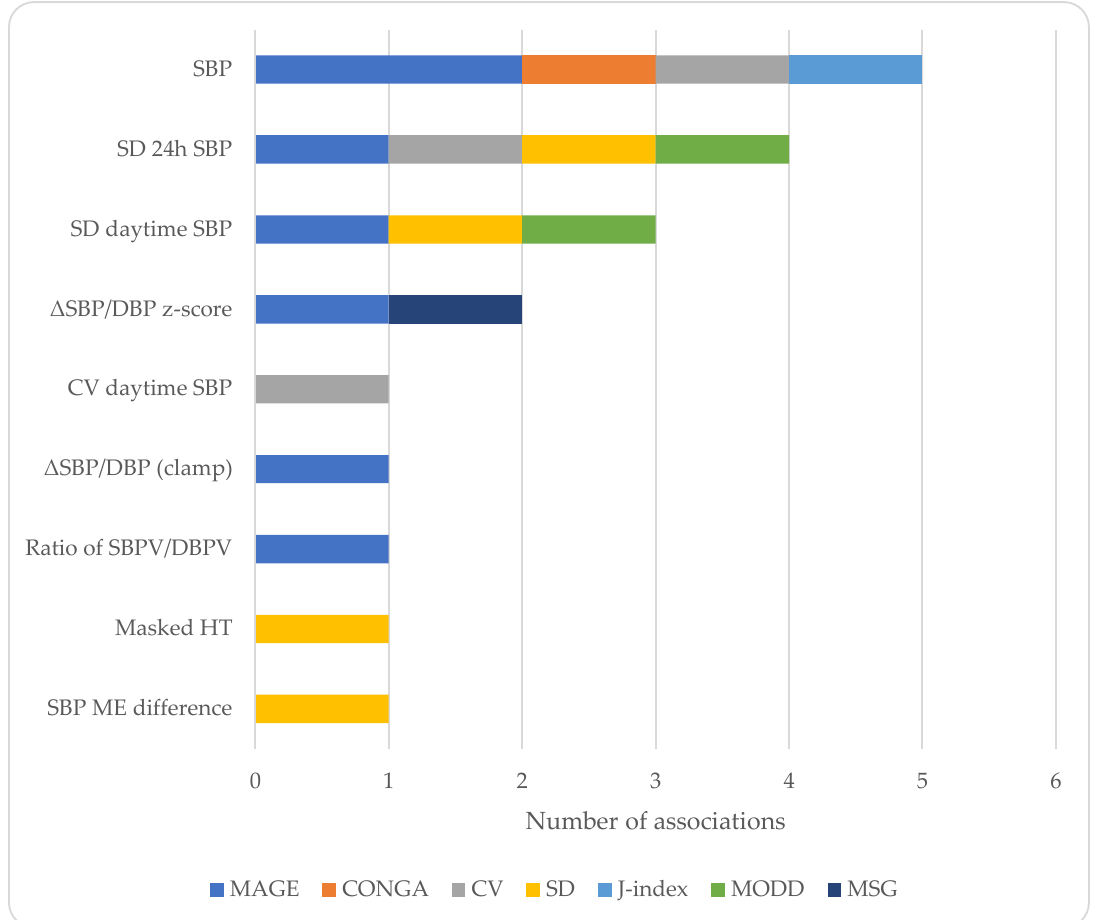
Figure 1. Charted representation of the extracted data. Only significant associations are shown. DBP: diastolic blood pressure, HT: hypertension, ME: morning–evening, MSG: mean sensor glucose, SBP: systolic blood pressure, SBPV/DBPV: systolic/diastolic blood pressure variability, SD: standard deviation, and ΔSBP/DBP: change in SBP/DBP.